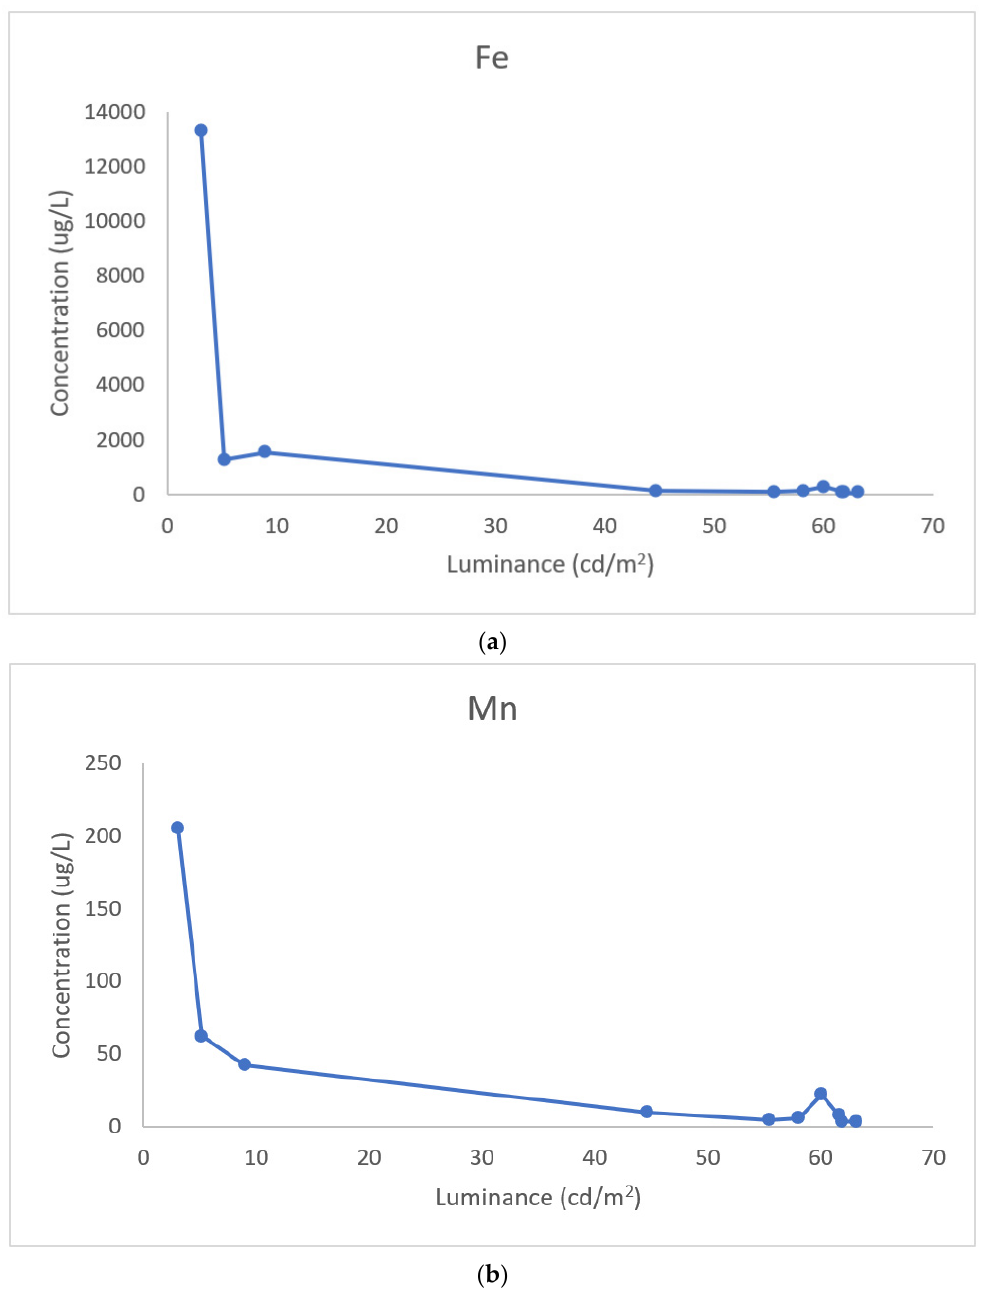
Figure 2. ( a ) Iron release ( μ g/L per gram of solid) versus reflected brightness. ( b ) Manganese release ( μ g/L per gram of solid) versus reflected brightness.